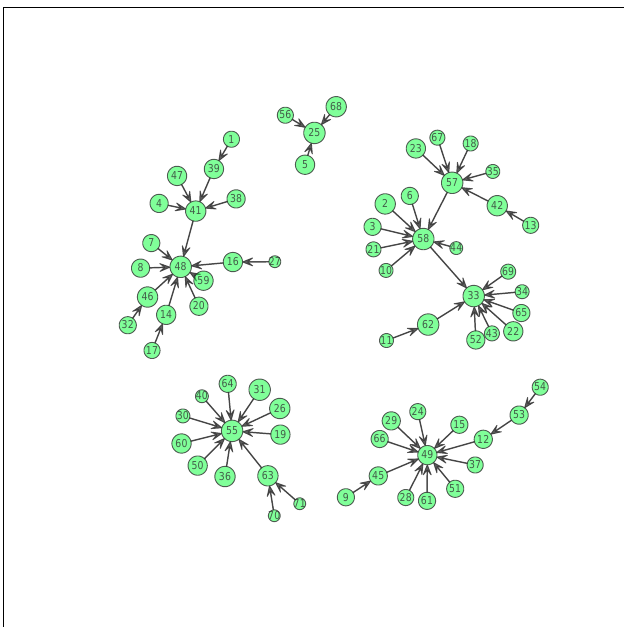
Figure 8. Forest obtained on a medical dataset. Data are diabetic (type 2) patients described by 10 features including age, sex, HBA1C, prescribed insulin, body mass index etc. Each vertex is a patient and the circle diameter is proportional to the DoR of the patient. The scale factor k is determined by the method proposed in the section